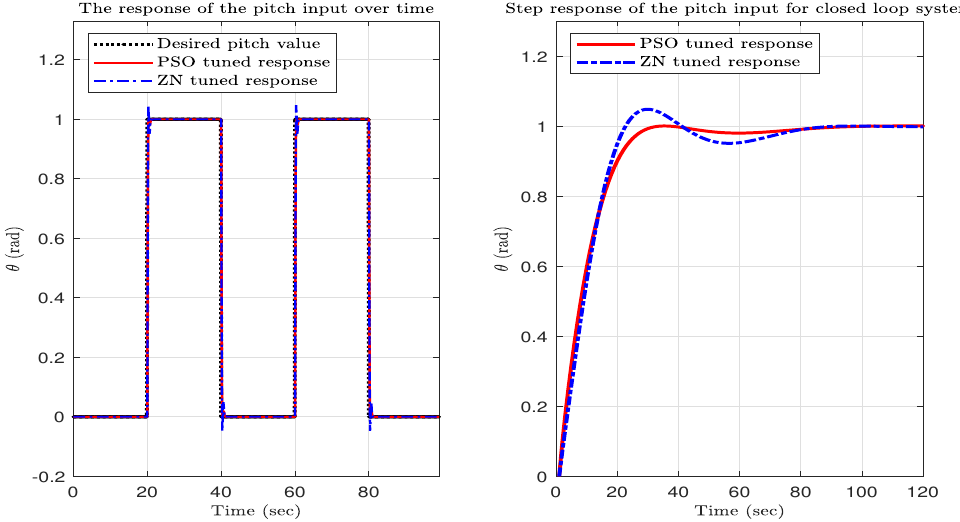
Figure 12. Simulated output responses of the pitch input of a quadcopter using PSO and ZN methods.